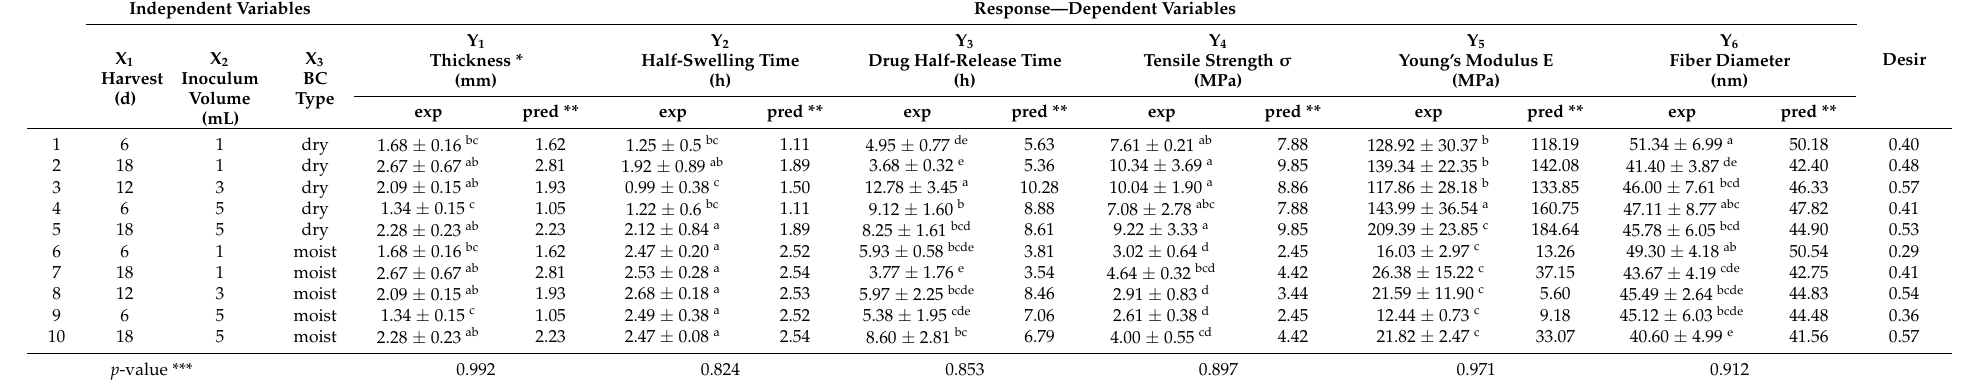
Table 2. The properties of bacterial cellulose (BC) of interest for biomedical purposes at different fermentation conditions based on a Box–Behnken design for response surface methodology (RSM).